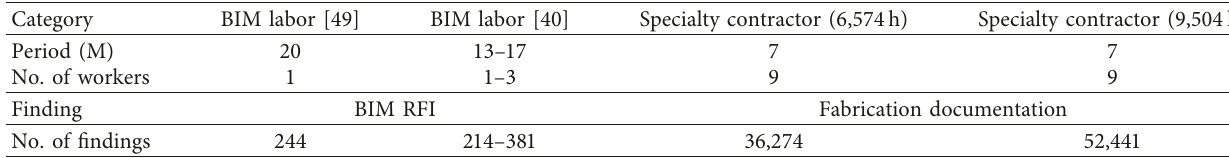
Figure 18: Probability of the number of BIM RFIs in the queuing Table 5: Comparison of labor input and findings.